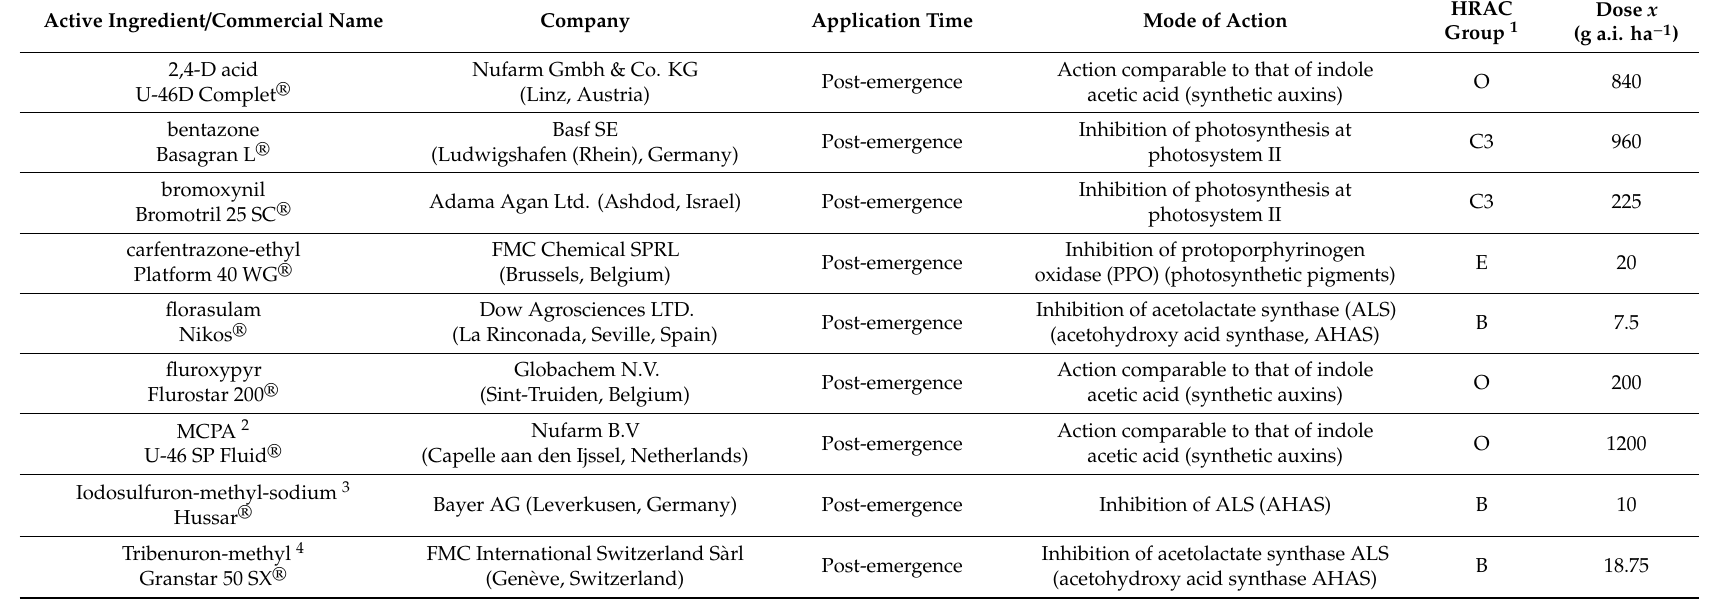
Table 1. Active ingredients tested in the trial searching for alternative herbicides for Rapistrum rugosum